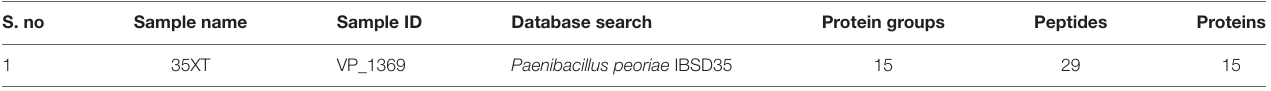
TABLE 2 | LC-MS analysis of the sample (VP_1369) using the SEQUEST search algorithm against the Paenibacillus peoriae IBSD35 Uniprot database. S.